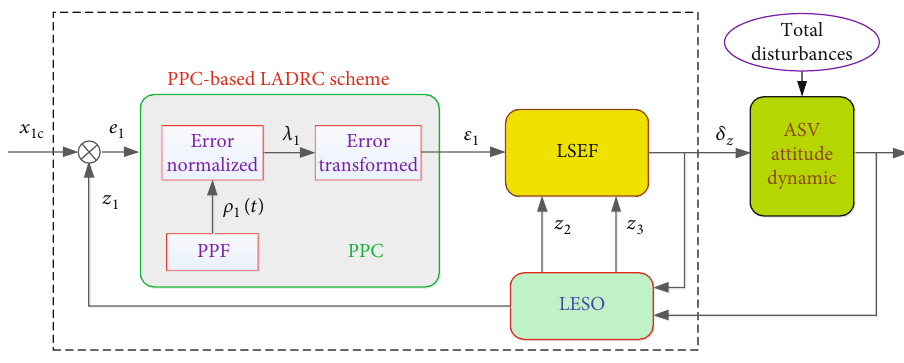
Figure 2: The block diagram of the presented